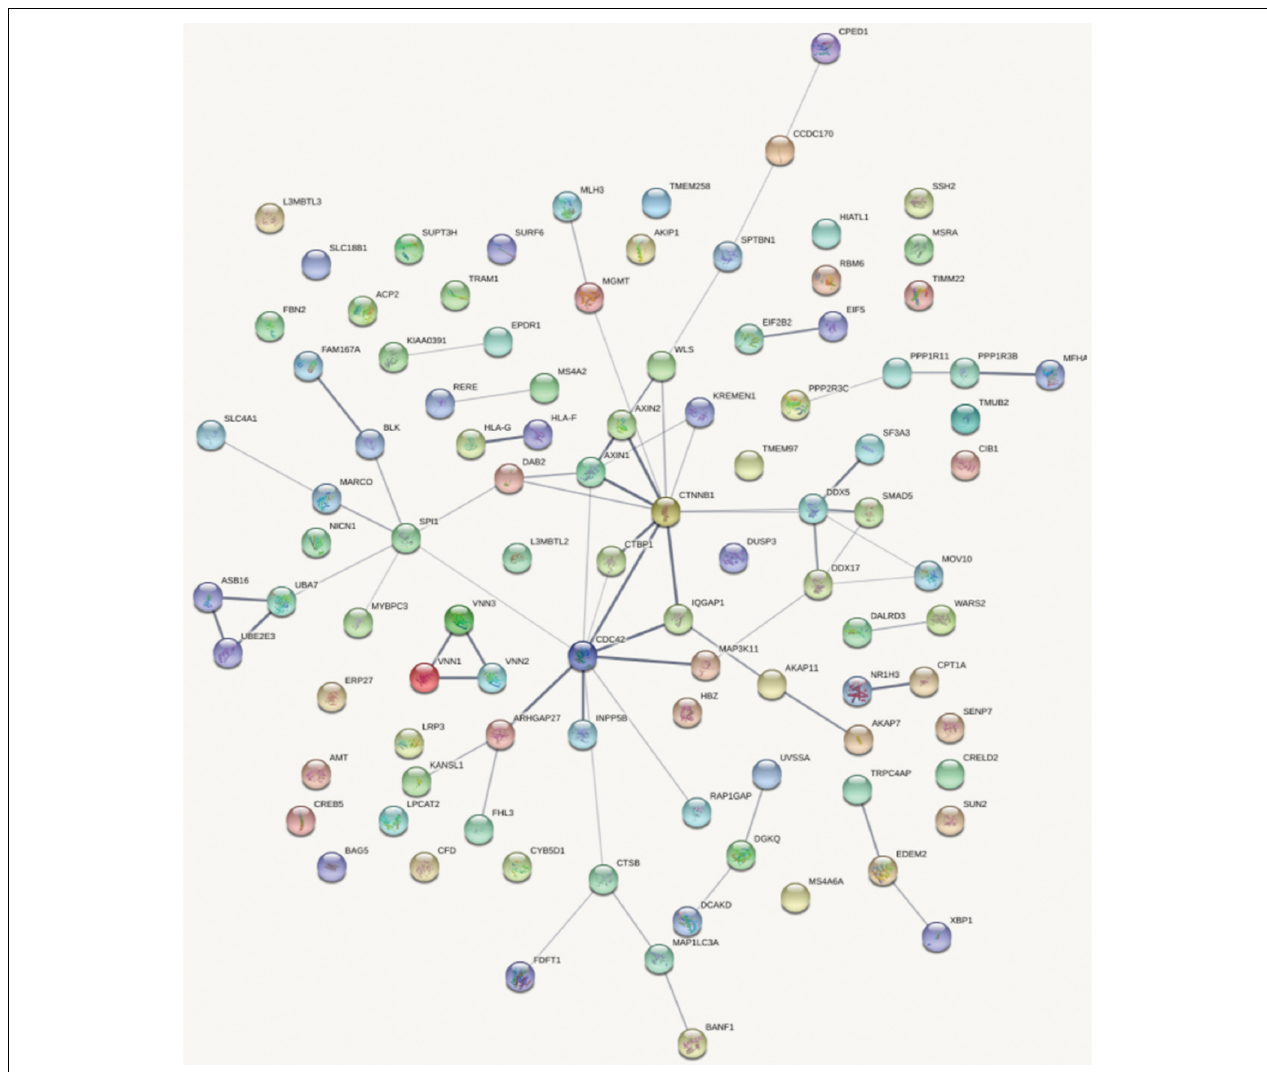
FIGURE 4 | Gene interaction network obtained from the top 100